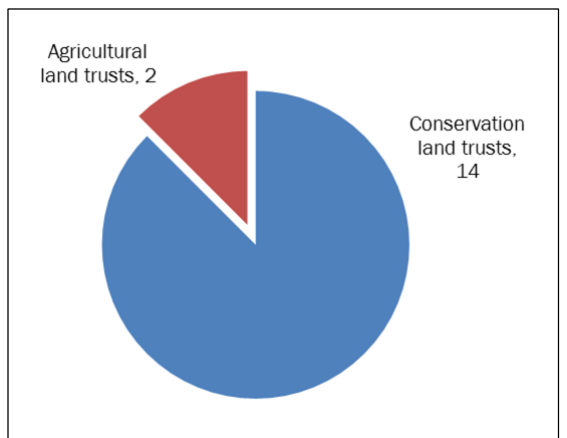
Figure 1. Number of Conservation Land Trusts and Agricultural Land Trusts in This